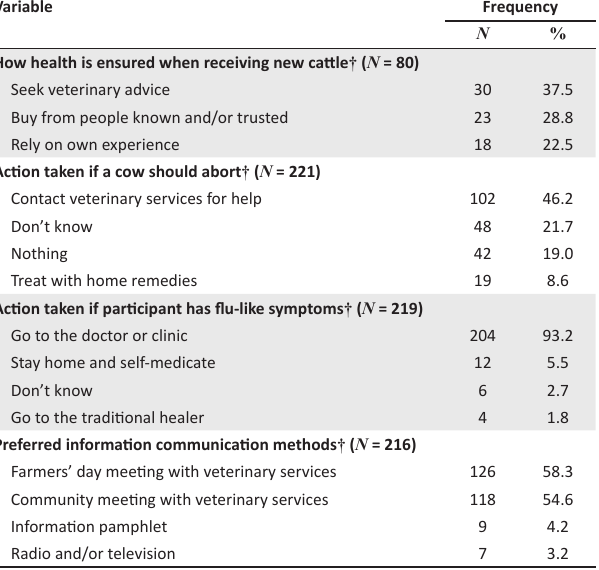
TABLE 3: Responses of participants to attitude questions towards animal health, human health and brucellosis, Whittlesea community, South Africa, 2017 (reflecting the outcome of some of the attitude